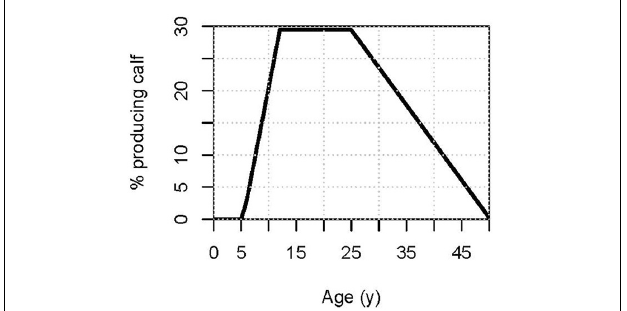
FIGURE 1 | Percent of females of each age producing a calf, as determined from a 3-part regression of breeding rate against age. Equation: %producing calf = 29.42 + 4.399 × (Age-12) × (Age < 12) − 1.165 × (Age-25) × (Age >